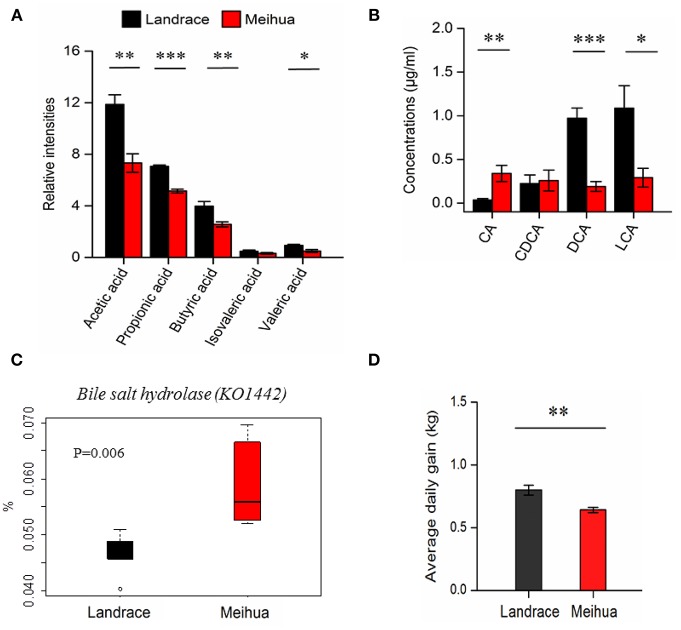
Quantification of short chain fatty acids (SCFAs) and bile acids in the colon lumen using the targeted metabolomics approach and average daily weight gain of piglets. (A) The relative levels of SCFAs in the colonic contents samples from Landrace and Meihua piglets. (B) The absolute levels of bile acids in the colonic contents samples from Landrace and Meihua piglets. CA, cholic acid; DCA, deoxycholic acid; CDCA, chenodexycholic acid; LCA, lithocholic acid. Error bar indicated the mean value ± SEM of each experimental group. (C) The relative abundance of bile salt hydrolase (K01442) from the colonic microbiota in Landrace and Meihua piglets. Based on the PICRUSt prediction and KEGG analysis, the KO term named K01224 was enriched in the pathways of primary bile acid biosynthesis and secondary bile acid biosynthesis. (D) Average daily weight gain of Landrace and Meihua piglets between days 30 and 65 of age. Results are shown as mean ± SE. *P < 0.05, **P < 0.01, and ***P < 0.001, respectively.